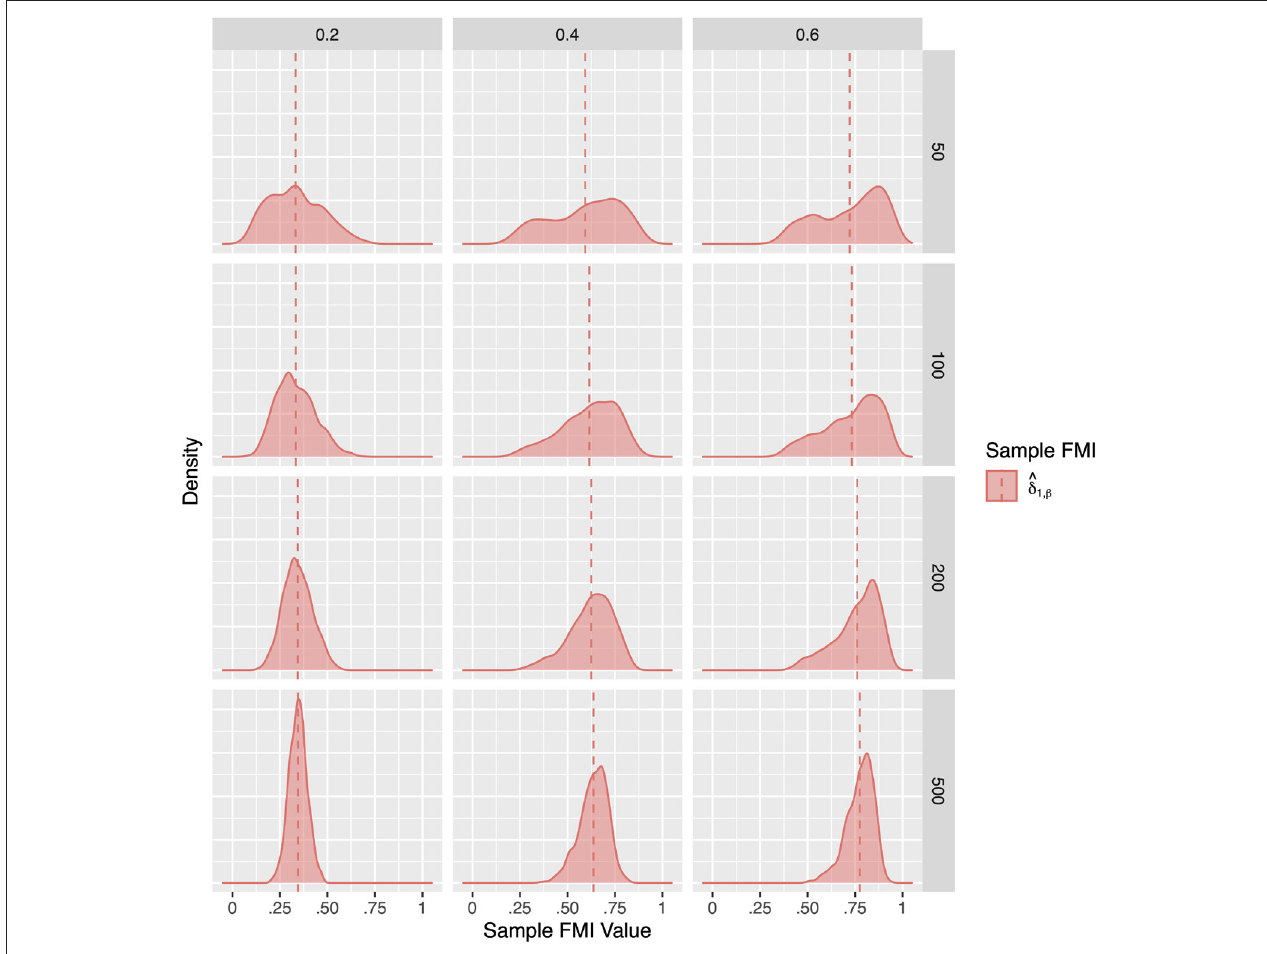
FIGURE 3 | The sampling distribution of FMI for regression coefficients in nonlinear MAR. The panel rows correspond to sample sizes of N The panel columns correspond to per variable missing rates of 20, 40, and 60%, or overall population missing rates of 10, 20, and 30%. The population FMI value in each panel is given as a vertical black dotted line. The sampling distributions of the three estimates are virtually identical in simple regression.